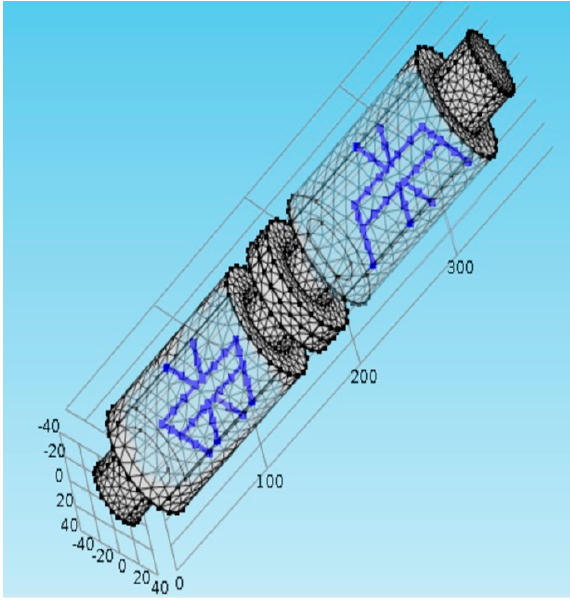
Figure 8. Representation of internal water ducts and the 3D geometry of the rotary valve.